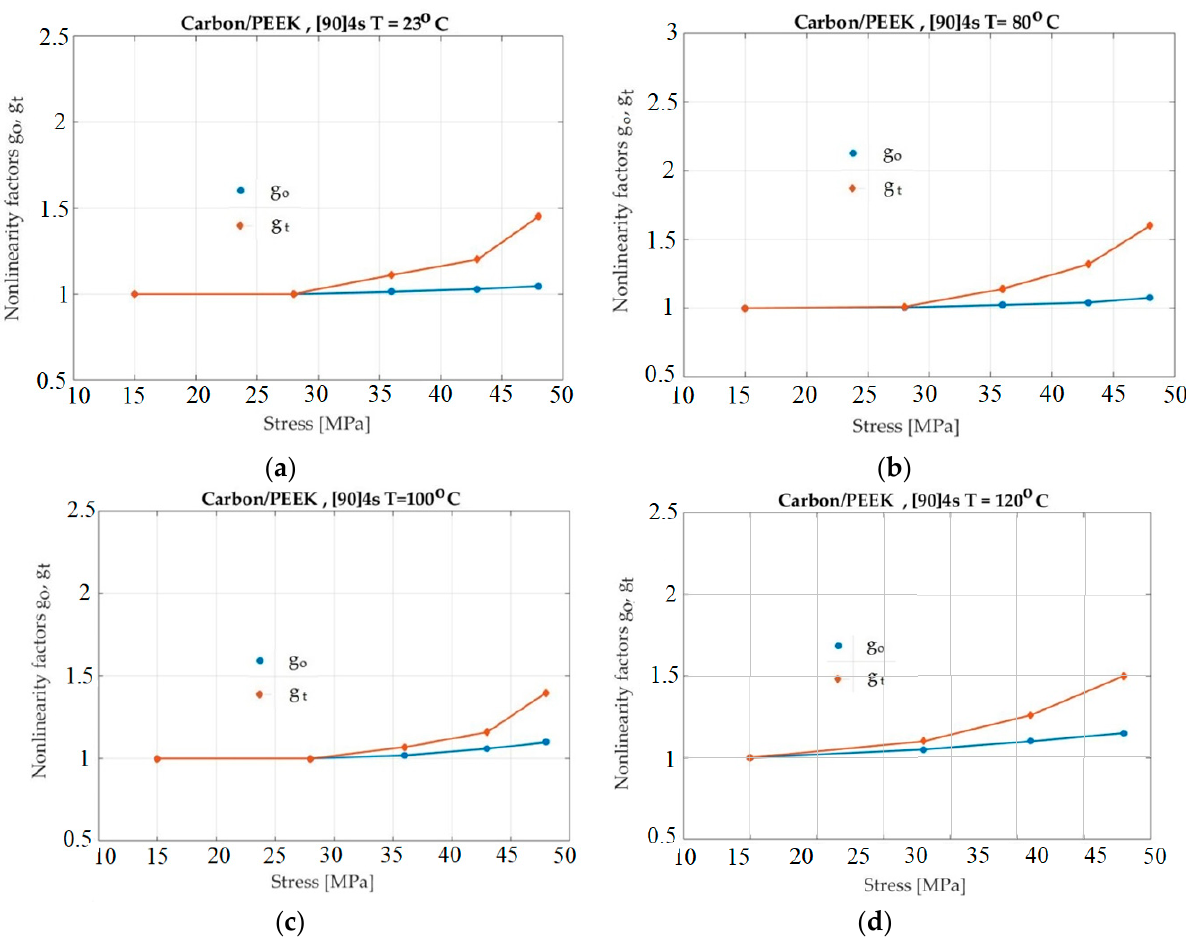
Figure 8. Plot of g o and g t for Carbon/PEEK as a function of stress and temperature: ( a )—T = 23 °C; ( b )—T = 80 °C; ( c )—T =